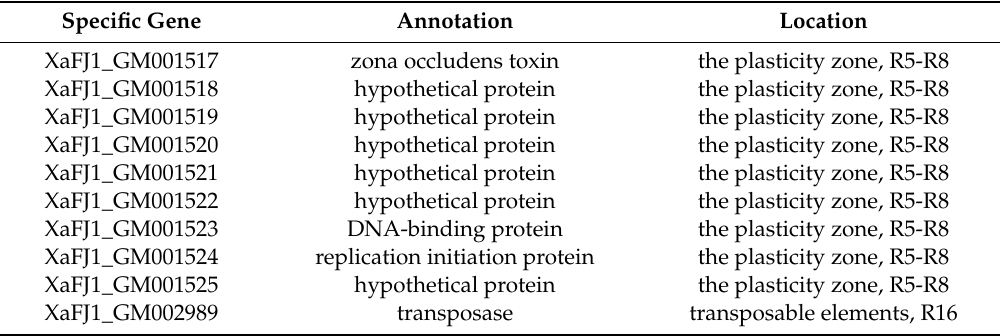
Table 3. Putative function of the 10 genes of the chromosome of X. albilineans strain Xa-FJ1 from China that were not present in the genome of strain GPE PC73 from